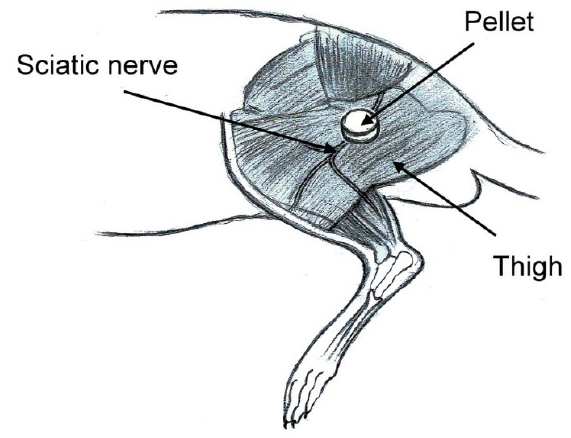
Figure 3. Schematic of the implantation of the lidocaine/PLGA pellet.